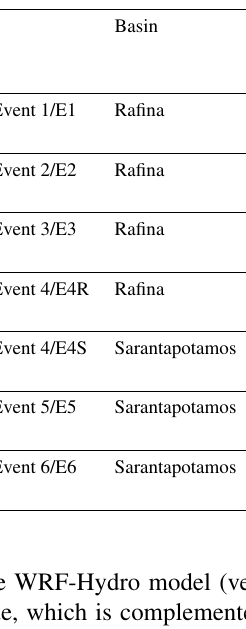
Table 7. Comparison of the basin average soil moisture (at the first level) and 6h accumulated latent heat flux simulated by the WRF-Hydro and WRF-only models, at the time before the beginning of the